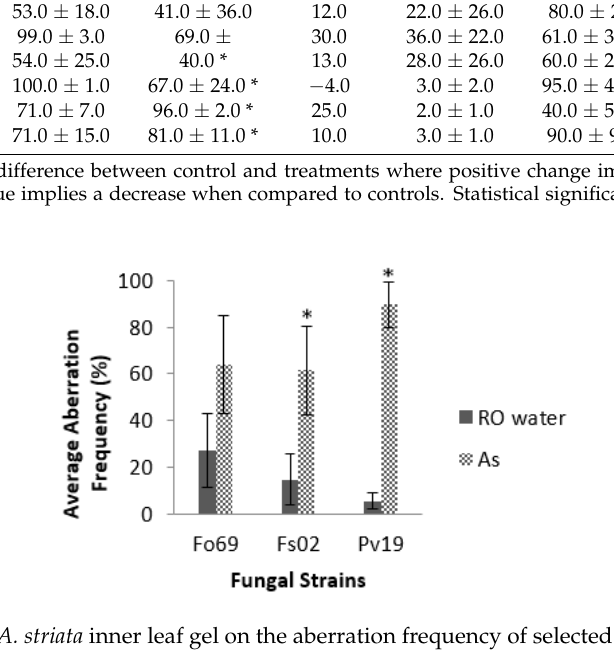
Figure 2. Effect of A. striata inner leaf gel on the aberration frequency of selected F. oxysporum (Fo69), F. solani (Fs02), and P. variotii (Pv19) strains in repeated germination assays. * Indicates statistical significance, error bars represent standard error of the mean, n = 200, p -value < 0.01.